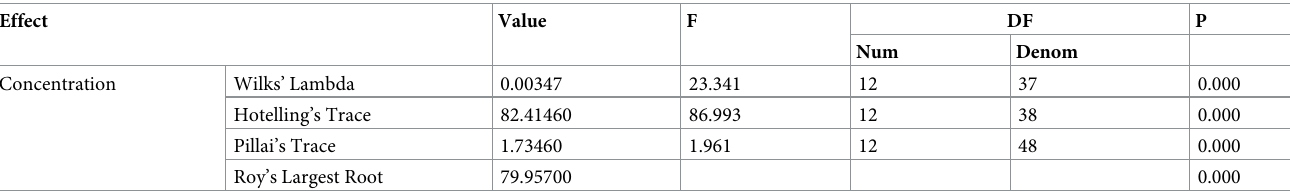
Table 3. Repeated measures MANOVA to identify significant variation in